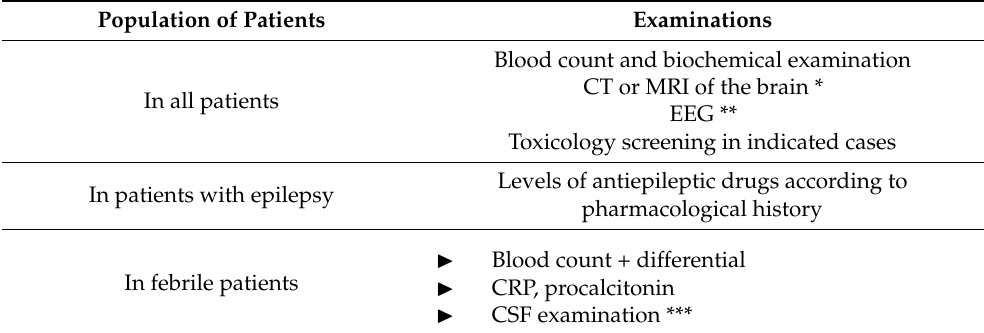
Table 1. Diagnosis of